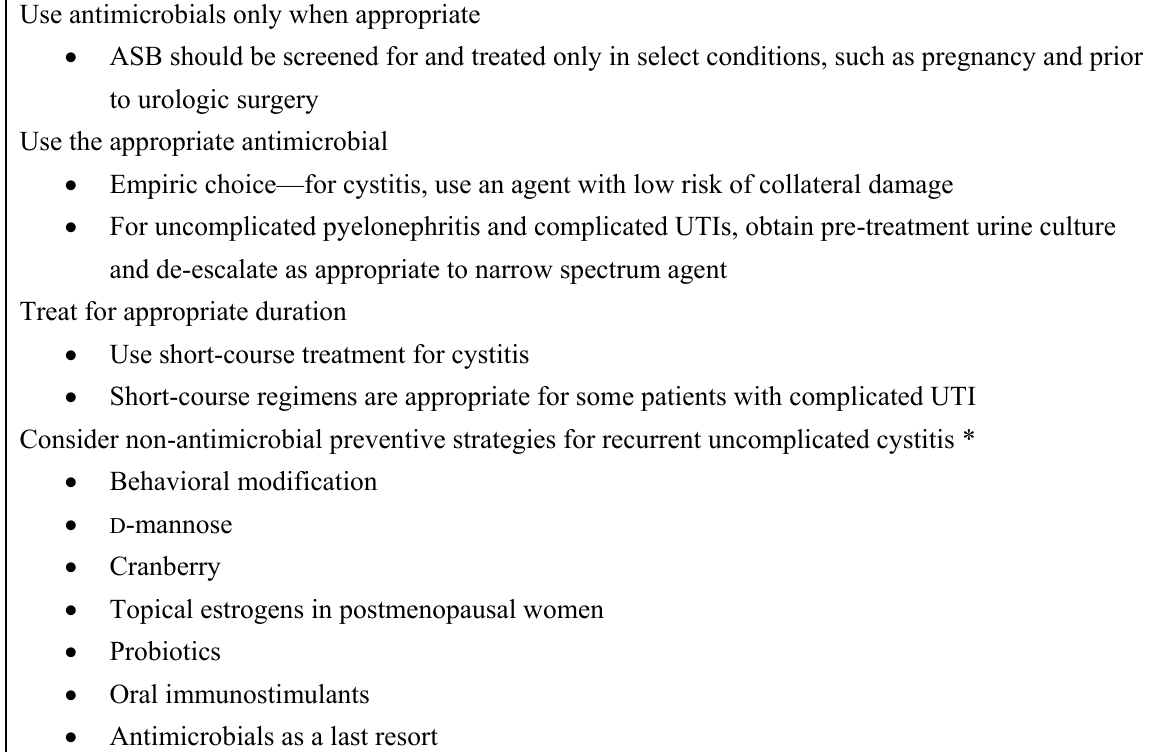
Table 1. Opportunities for antimicrobial stewardship and urinary tract